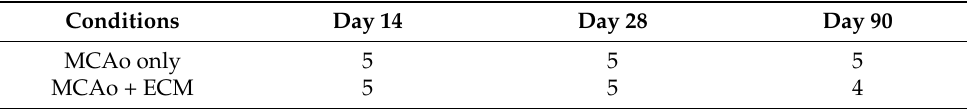
Table 1. Number of animals assigned to experimental condition.